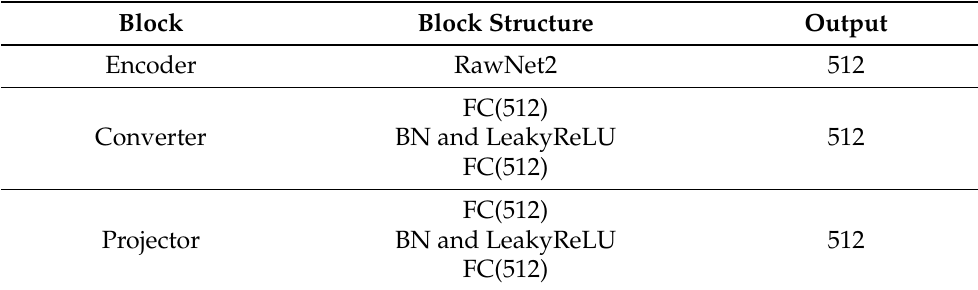
Figure 1. Overall structure of the proposed method. The student and mean teacher (MT) networks comprise an encoder f and converter g , and the projector q is added only to the student network. The two networks are fed by separate minibatches m and m (cid:48) , and extract the embeddings Z and Y (cid:48) , respectively. The student network is trained by cosine similarity-based metric learning using Y (cid:48) , along with speaker identification. The parameter set of the MT network ξ is updated with the exponential moving average of the student network parameter set θ . Table 2. The student network architecture of the proposed method. RawNet2 used as the baseline in this study is exploited as the encoder. The mean teacher network has an identical structure as the student network except for the